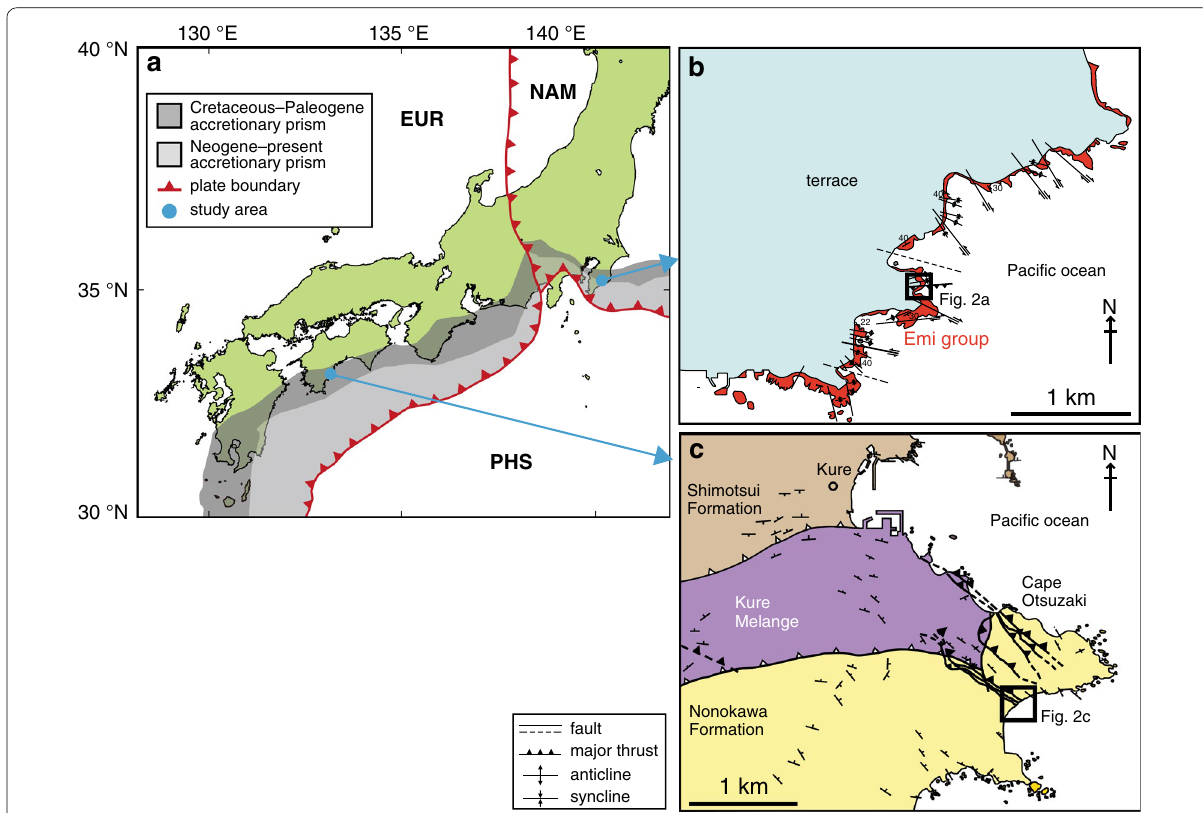
Fig. 1 Location and geology of the studied area. a Regional map showing major plate boundaries, the distribution of accretionary complexes of the Japan island arc, and the locations of the two study areas of this paper. EUR Eurasia plate, NAM North America plate, PHS Philippine Sea plate. Maps showing simplified geologic structure in b the area of outcrop of the Emi Group, modified from Hirono et al. (2008b), and c OSTs around the Kure Mélange, modified from Honda et al.